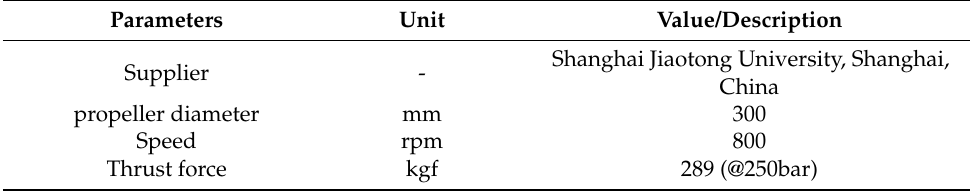
Table 8. Propeller parameters.